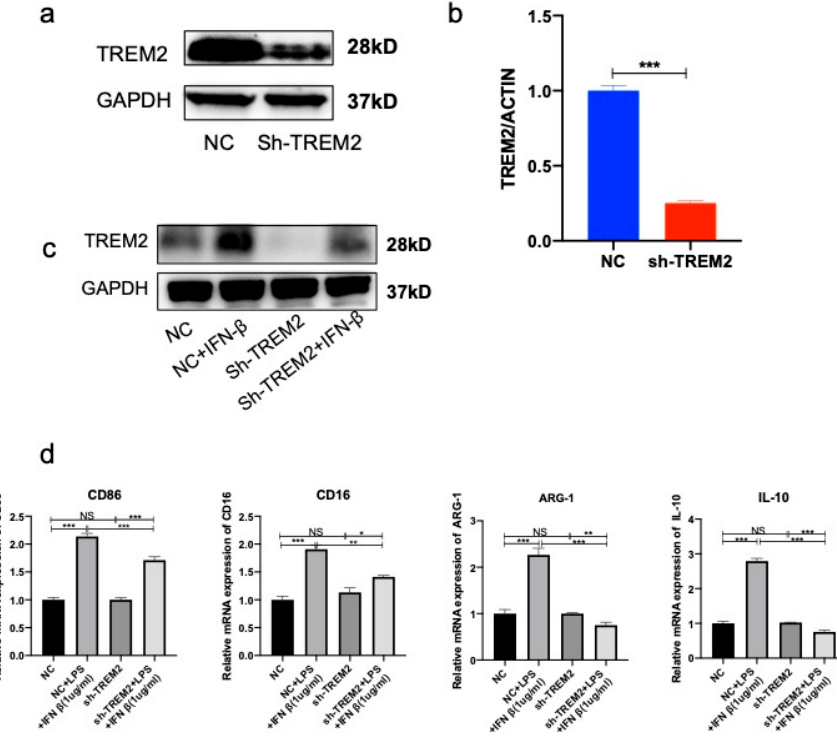
Figure 7. IFN- β increases TREM2 expression and promotes microglia polarization toward M2 phenotype in TREM2 knockdown BV-2 cells. ( a ) Protein expression in shTREM2-transfected BV-2 cells. ( b ) mRNA expression in shTREM2-transfected BV-2 cells. ( c ) Protein expression of TREM2 after 24 h treatment of sh-TREM2 and NC cells with different concentrations of IFN- β . ( d ) mRNA expression of M1-type microglia markers (CD16 and CD86) and M2-type microglia markers (Arg-1 and IL-10) by PCR. NS indicates no statistical difference from the control group. * p < 0.05, ** p < 0.03, *** p < 0.01 compared with control, n = 6 mice per group.